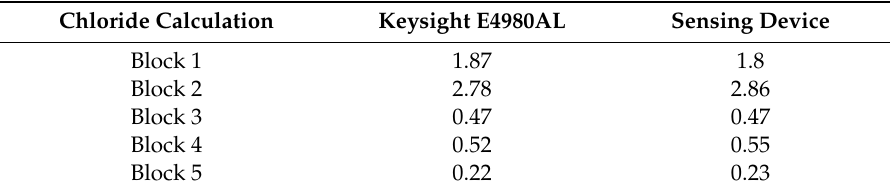
Table 3. Experiment 1 chloride calculation results in